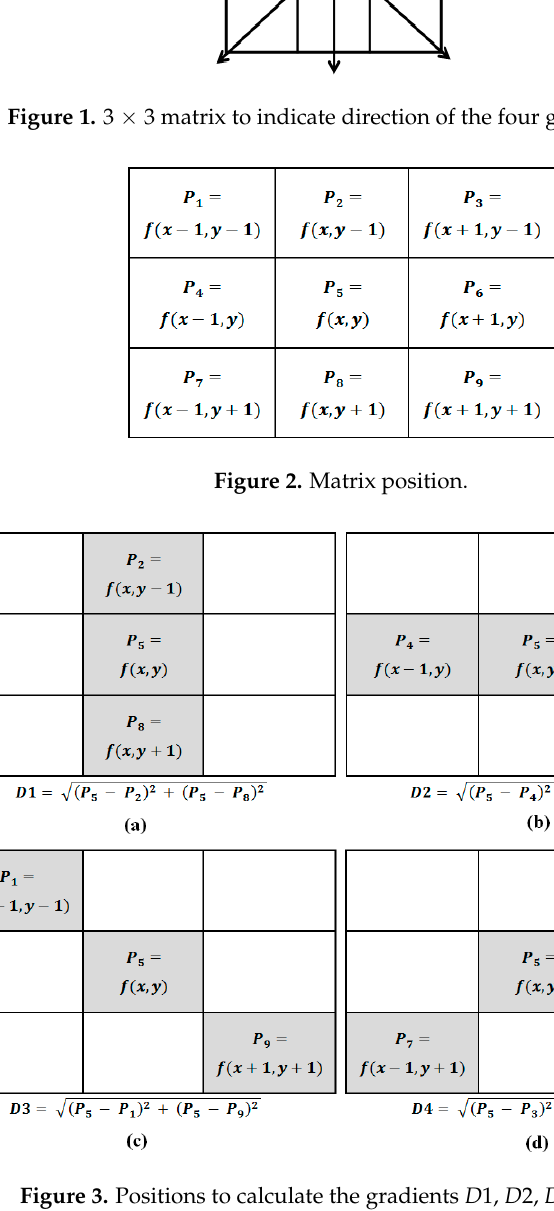
Figure 3. Positions to calculate the gradients D 1, D 2, D 3, and D 4.